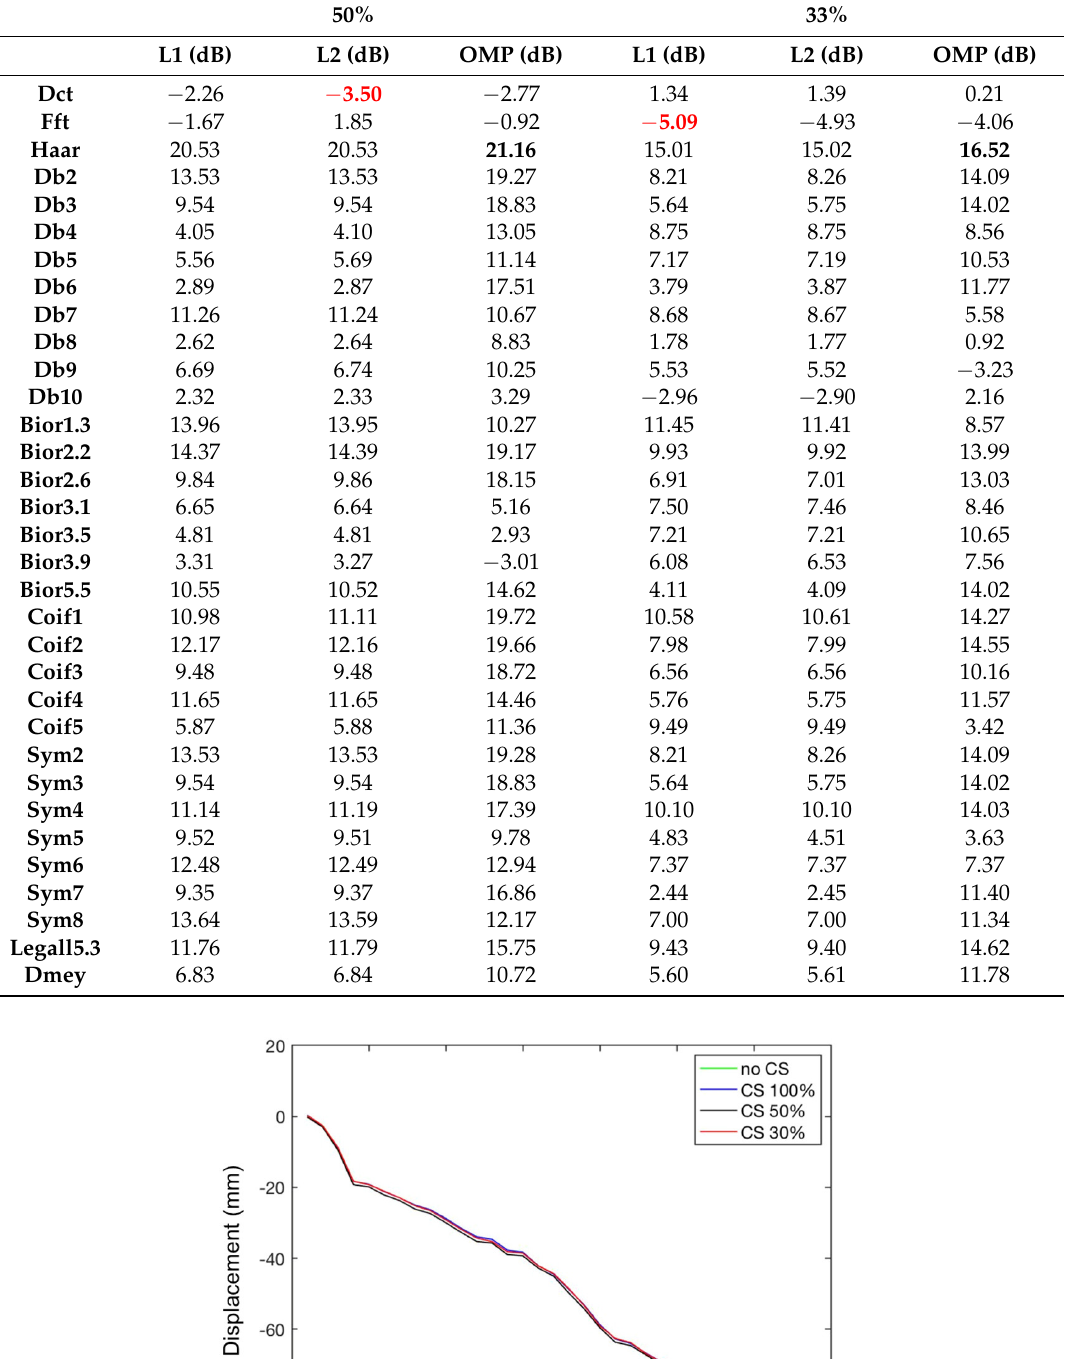
Table 4. PSNR calculated with different bases and recovery methods for experimental data acquired at a glacier in the Italian Alps.